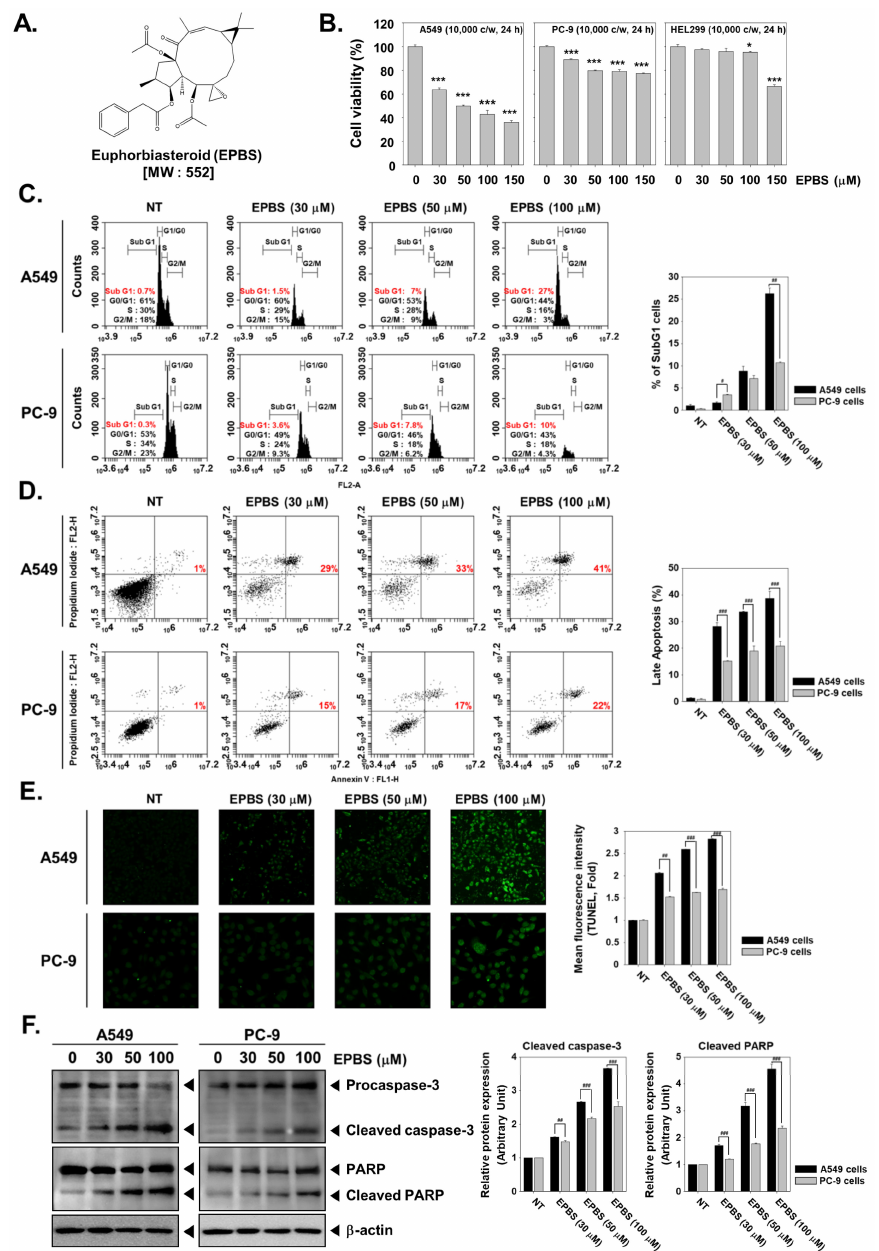
Figure 1. EPBS induces apoptosis and increases the subG1 cell population in NSCLC cells. ( A ) The chemical structure of EPBS. ( B ) Human NSCLC A549 cells, PC-9 cells, and human lung